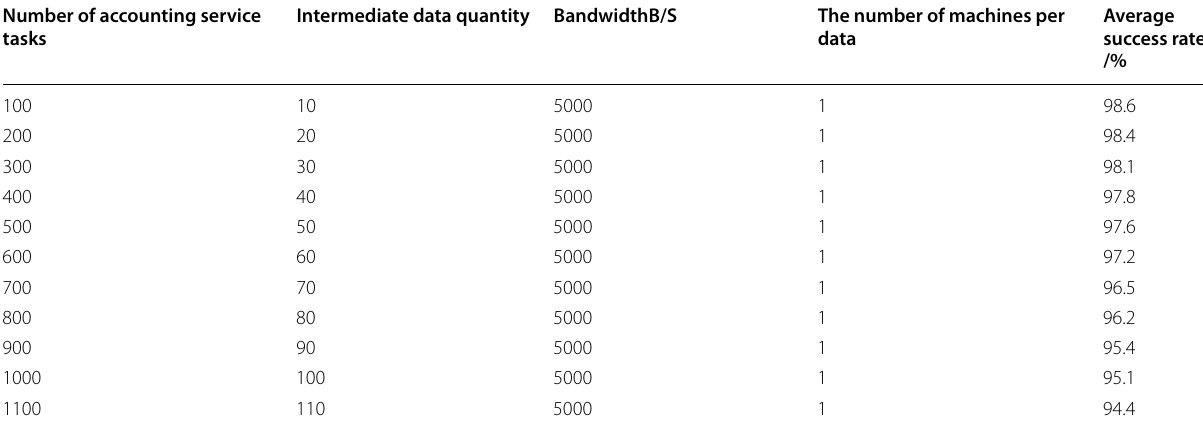
Table 1 Average success rate analysis of this method